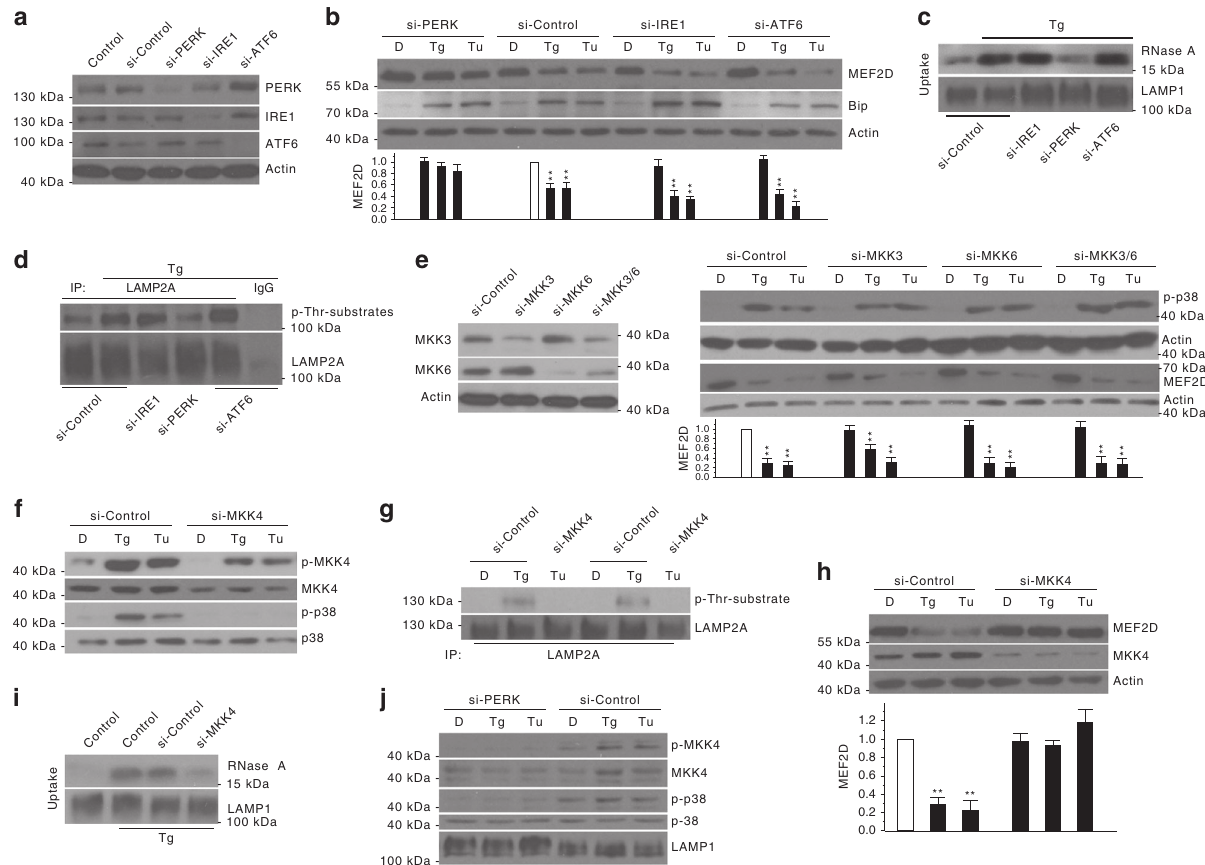
Fig. 5 PERK and MKK4 are required to activate the p38 MAPK – CMA pathway under ER stress. a siRNAs effectively knockdown PERK, IRE1, and ATF6. SN4741 cells were transfected with siRNAs for 72 h. b , c Knockdown of PERK abolishes the activation of CMA by ER stress. SN4741 cells were transfected with siRNAs for 60 h, then treated with Tg (0.3 μ M) or Tu (3 μ g/ml) for 12 h, and assessed for endogenous CMA substrate MEF2D level b and RNase A uptake c . d Knockdown of PERK reduces p-LAMP2A. SN4741 cells were transfected siRNAs for 69 h, and then treated with Tg for 2 h. e MKK3 and 6 are not involved in ER stress-induced CMA. SN4741 cells were transfected with si-Control, si-MKK3, si-MKK6, and si-MKK3 as well as 6 (MKK3/6) for 72 h. Total proteins were blotted with MKK3 and MKK6 antibodies (left). SN4741 cells were transfected for 70 h and exposed to Tg or Tu for 2 h for p-p38 MAPK (top right) or transfected for 60 h and exposed to Tg or Tu for 12 h for MEF2D (bottom right). f , g Knockdown of MKK4 attenuates activation of p38 MAPK and phosphorylation of LAMP2A induced by ER stress. SN4741 cells were transfected with si-Control and si-MKK4 for 70 h, and then treated with Tg or Tu for 2 h ( f ) or transfected for 69 h and stressed for 3 h ( g ). h , i Knockdown of MKK4 reverses the reduction of MEF2D induced by ER stress. SN4741 cells were transfected with si-Control and si-MKK4 for 60 h, treated with Tg or Tu for 12 h, and assessed for MEF2D level ( h ) and RNase A uptake ( i ). j Knockdown of PERK reverses the activation of MKK4 and p38 MAPK by ER stress. SN4741 cells were transfected with si-Control and si-PERK for 70 h, and then treated with Tg or Tu for 2 h. Quanti fi cations are shown for b , e , and h ( n = 3. All values are s.d. (one-way ANOVA with Turkey test). ** p < 0.005 vs. control and ## p < 0.005 vs. corresponding challenge